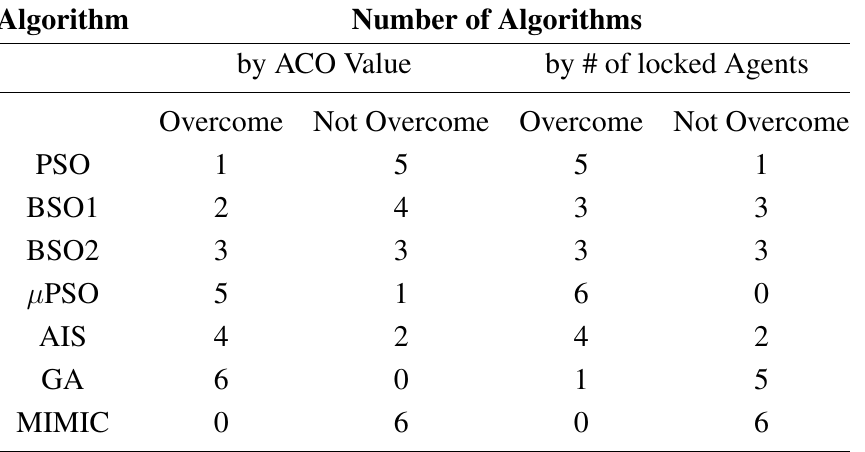
Table 10. Comparison among algorithms based on Wilcoxon